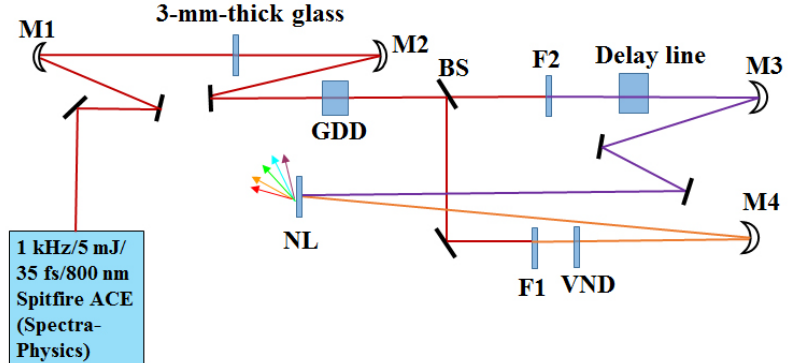
Figure 4. Type-2 experimental setup. Focal lengths of concave mirrors, M1, M3, and M4 are 500 mm, while that of M2 is 250 mm. GDD: chirped mirrors. F1: longpass filter with a cut-off wavelength of 800 nm. F2: short-pass filter with a cut-off wavelength of 800 nm. BS: beamsplitter. VND: variable neutral-density filter. NL: nonlinear medium for multicolor pulse